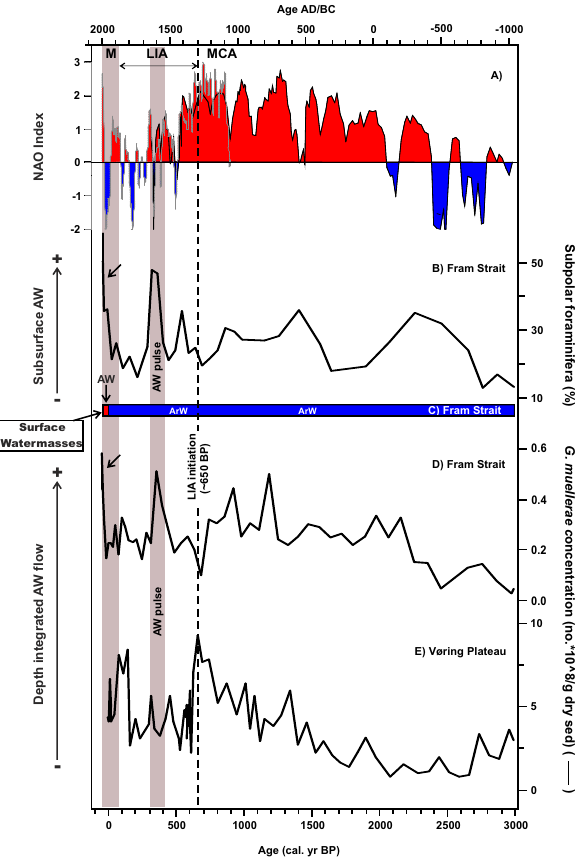
Fig. 7. Summary plot of surface and subsurface circulation changes across the eastern Nordic Seas over the past 3000yr. (A) Combined NAO index reconstruction based on Trouet et al. (2009) and Olsen et al. (2012); red area represents positive NAO and blue area negative NAO conditions. (B) Relative abundance of subpolar foraminifera (fraction > 100µm) at site HH11-134-BC as an index of subsurface AW masses. (C) Dominating surface water masses at site HH11- 134-BC (Fram Strait) inferred from E/C ratios. (D) (E) Dynam- ics of AW flow off western Svalbard (top) and off western Norway (bottom) inferred from absolute concentrations of the AW inflow species G. muellerae . The grey shaded areas indicate the marked inflow increases during the modern period and the intra-LIA event centered at 330–410calyrBP. The dashed, thick line refers to the initiation of the LIA according to Miller et al.